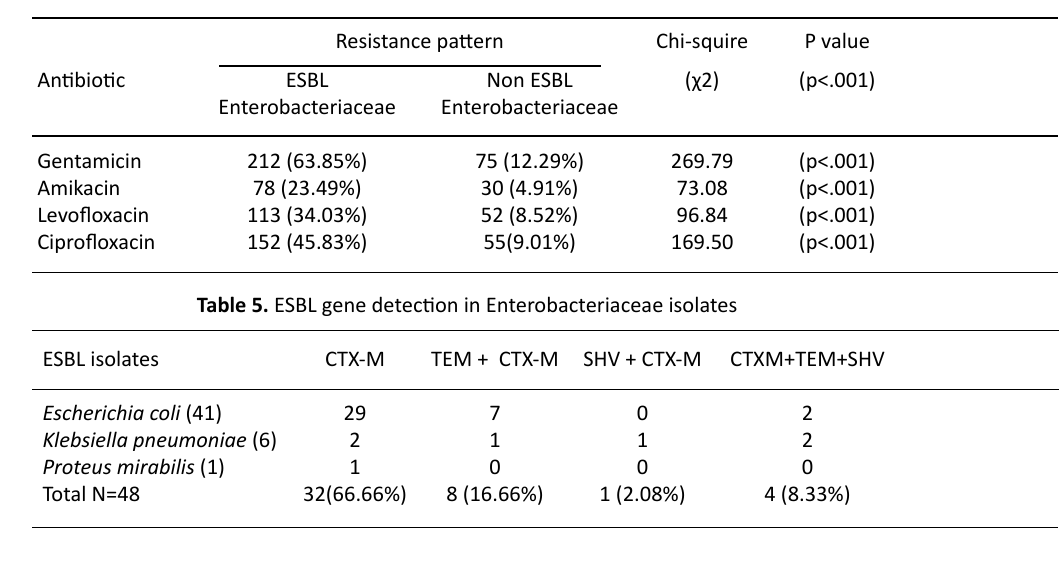
table 4. Comparison of Antibiotic resistance pattern between ESBL producer and non-ESBL producers of family Enterobacteriaceae Resistance pattern Chi-squire Antibiotic